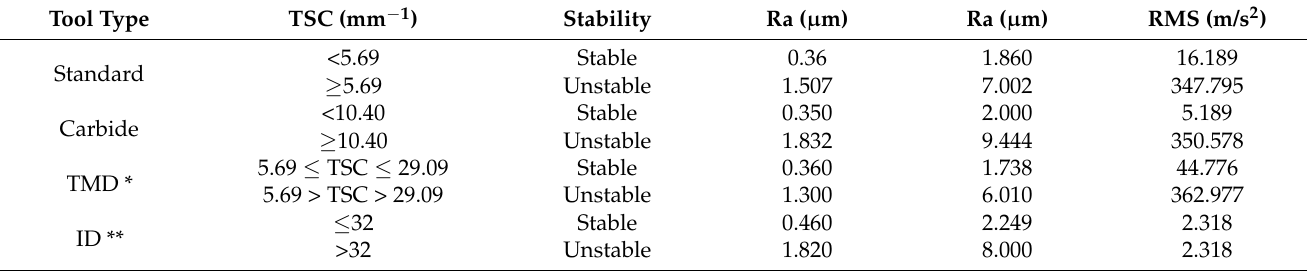
Table 3. Measured parameters are in terms of the average values of roughness (deviation ± 0.02 mm) and acceleration amplitude (deviation ± 0.1 m/s 2 ) of the tip of the